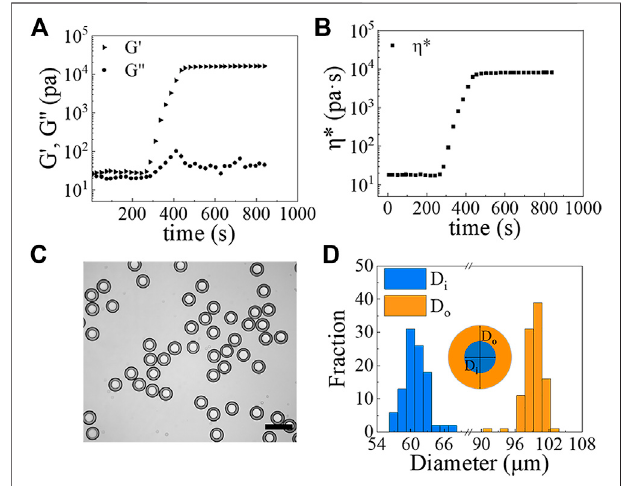
FIGURE6|(A,B) TherheologicalpropertiesofthePDMSmixtureversus time at 80 ° C: (A) G ’ (triangle), G ” (circle); (B) η * (square). (C) Image of PDMS microcapsules formed from w/PDMS/w DE droplets. Scale bar represents 200 μ m. (D) Size measurements of microcapsules (N ≥ 100).